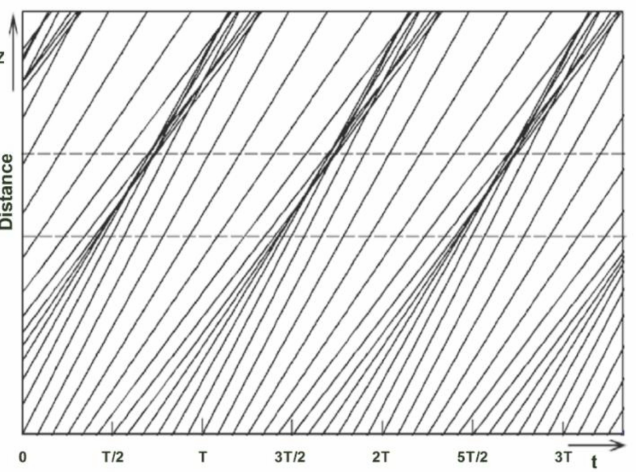
Figure 14. Trajectories of electrons with different velocities and starting time at z = 0. Electron bunching as a function of position and time is